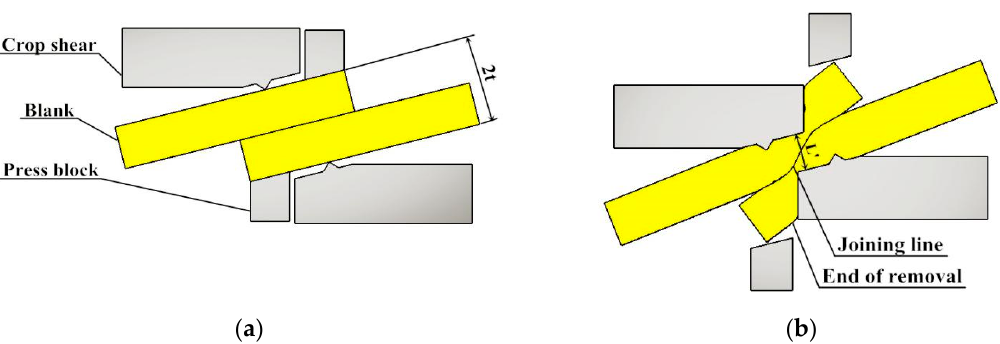
Figure 9. Process of cut connection: ( a ) before cutting the connection; ( b ) after cutting the connection.